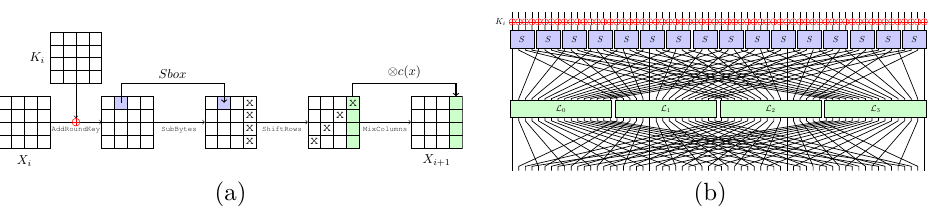
Figure 4: Schematic of one round of (a) AES and (b) PRIDE block